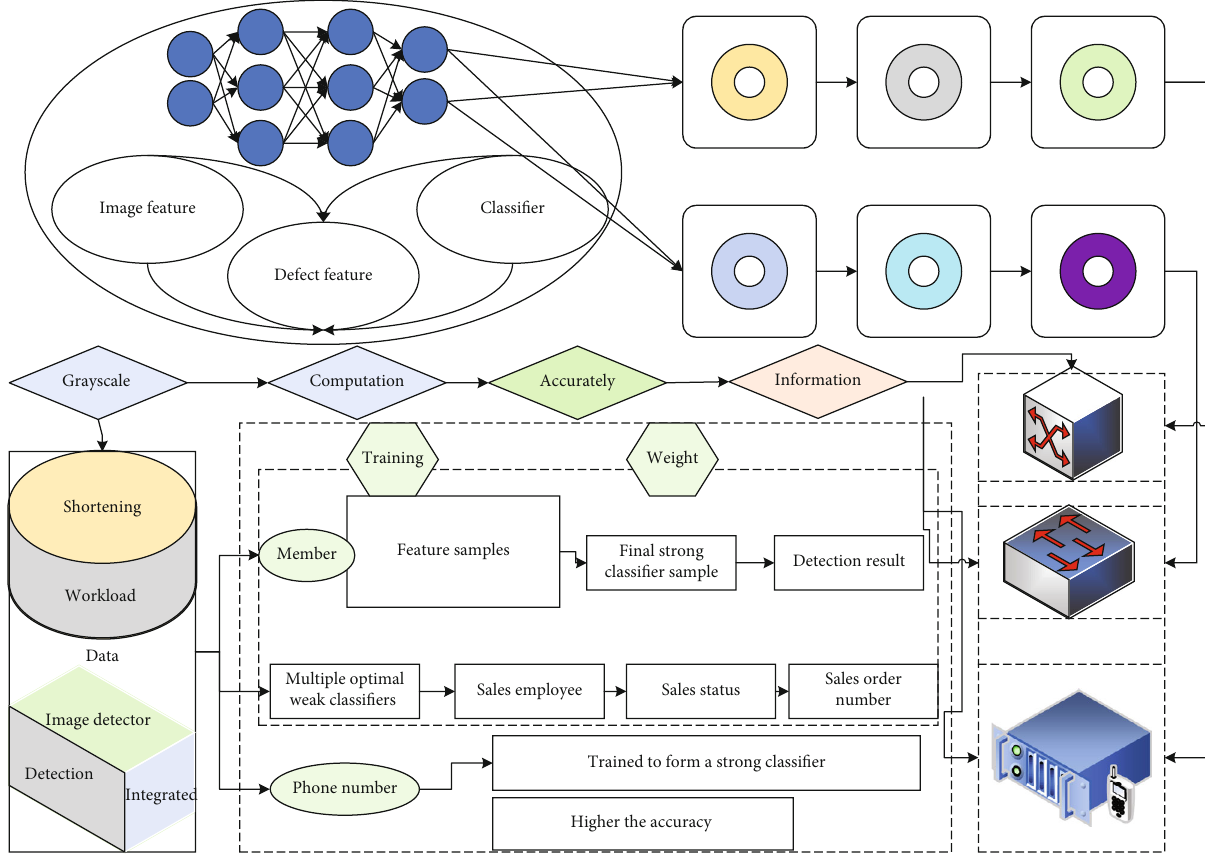
Figure 1: Visual detection principal